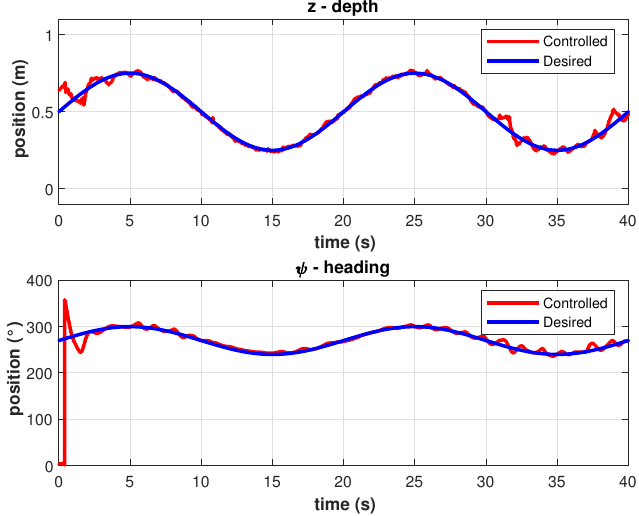
Figure 10. Best controlled trajectories with the asymptotic model-free 2nd-order SMC. Results for the trajectory tracking by the model-free high-order SMC with finite-time convergence in a predefined time-base of 5 s are shown in Figure 11. Note that, at the beginning of the controlled trajectory, the BlueROV2 approaches slowly to the desired trajectory and then accelerates to reduce the error to practically zero in the selected time- base of 5 s. After the time-base is reached, the controller maintains the robot in the desired trajectory with a minimum Root Mean Square Error (RMSE) (<1 cm and <2.3°) as can be seen in Figure 12. Those errors can be attributed to hardware limitations such as sensor accuracy, resolution, and measurement rates, processor speed, communication baud rates, etc., which limits the control cycle frequency to a maximum of 10 Hz compared with a frequency 100 to 1000 times higher in